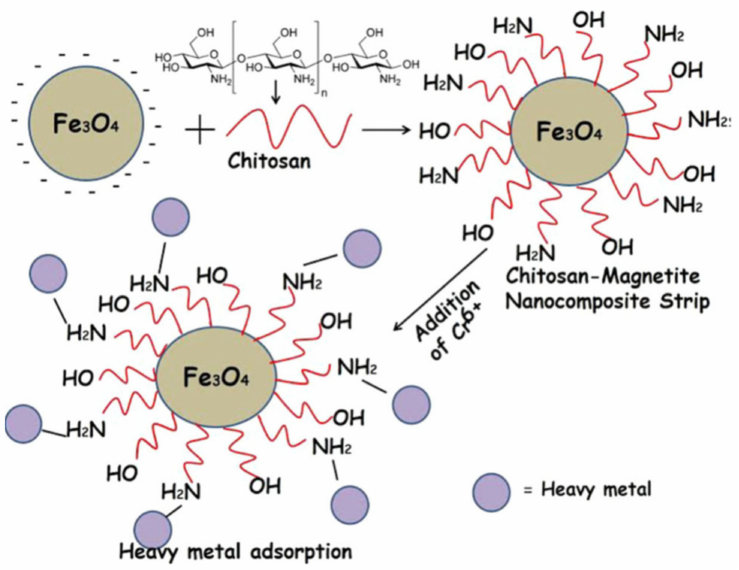
Figure 5. Schematic representation of removal mechanism of chromium ions by chitosan-magnetite nanocomposite strip. Reproduced with permission from